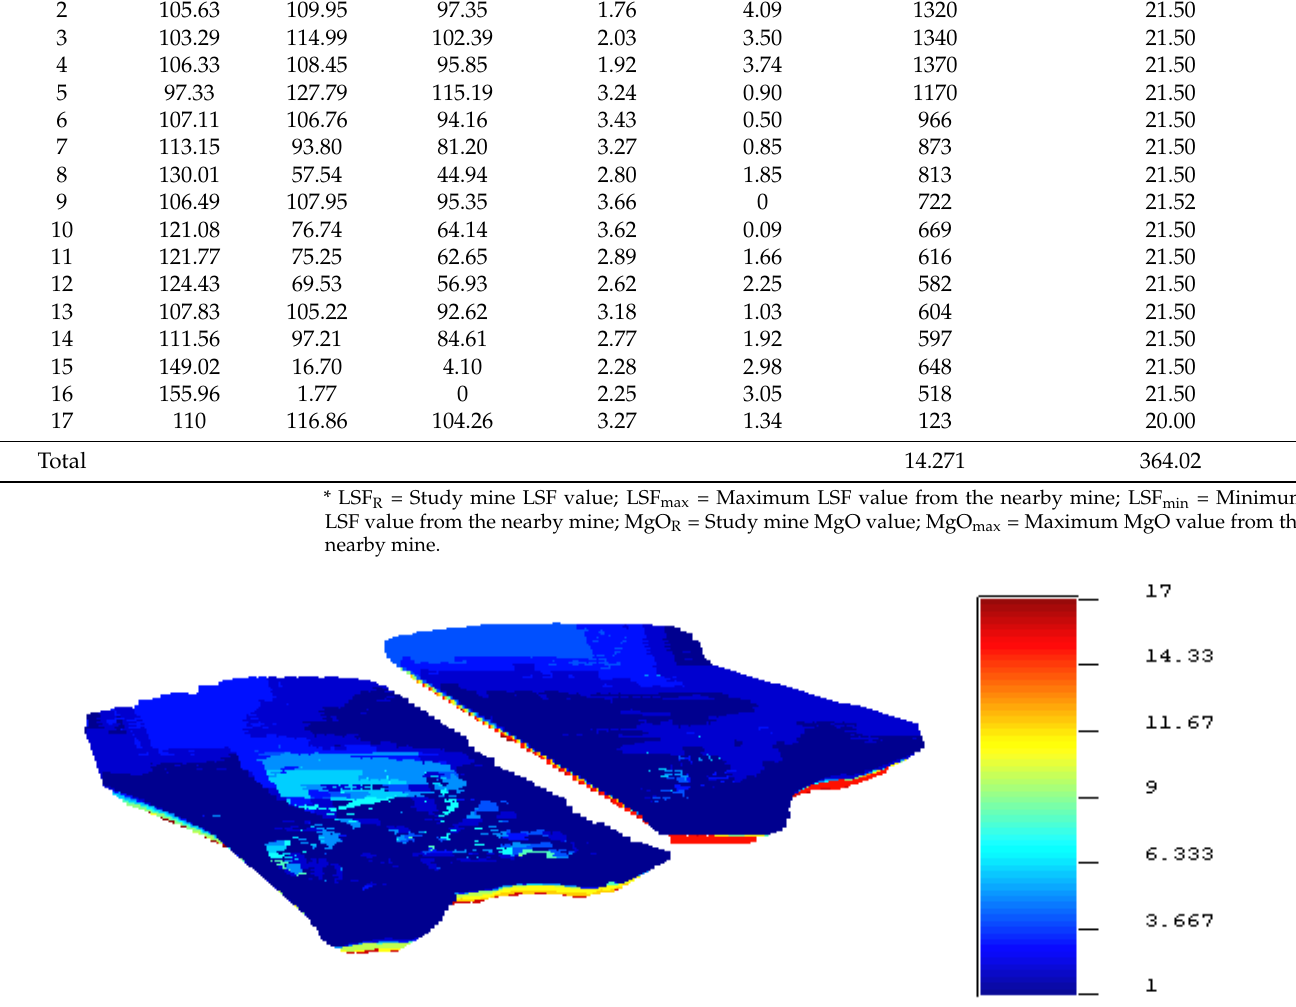
Figure 15. Model 2 final ultimate pit and production schedule (legend represents a period of extrac- tion). Table 3. Production scheduling results of Model 2.